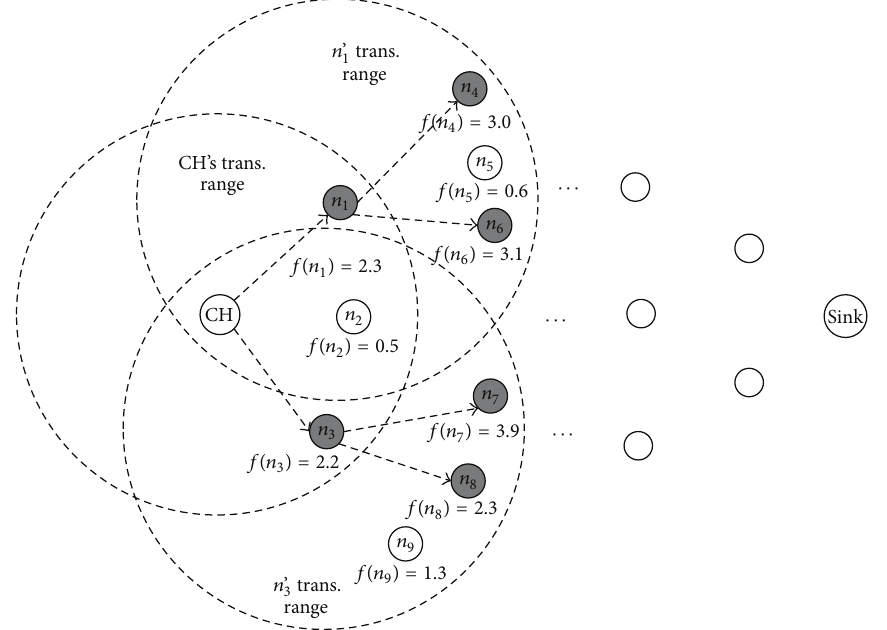
Figure 6: Key dissemination in the proposed method.